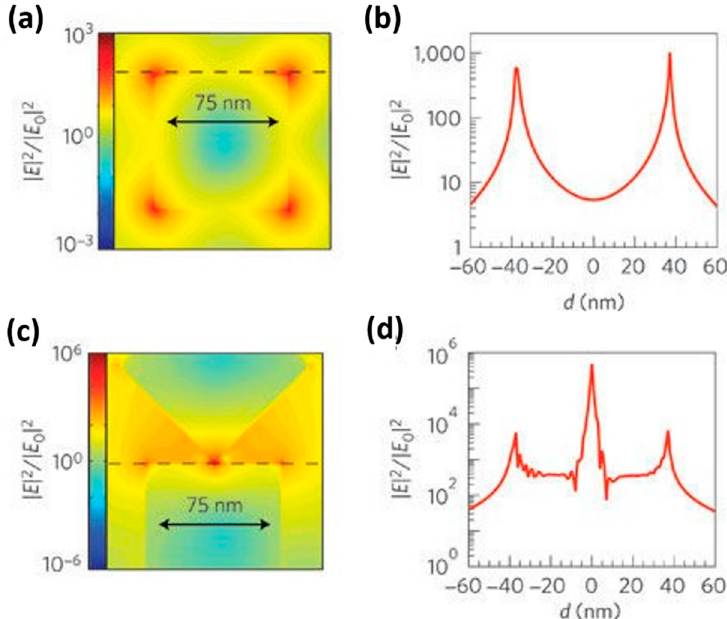
Figure 71. Finite difference time domain (FDTD) simulation of electric field intensity spatial distribution under 420 nm irradiation of ( a ) single 75 nm Ag nanocube; ( c ) two 75 nm Ag nanocubes separated by a distance of 1 nm (one cube is rotated 45 ◦ ); ( b , d ) Electric field intensity enhancement as a function of distance along the dashed line in left figure respectively. Reproduced with permission from [122].